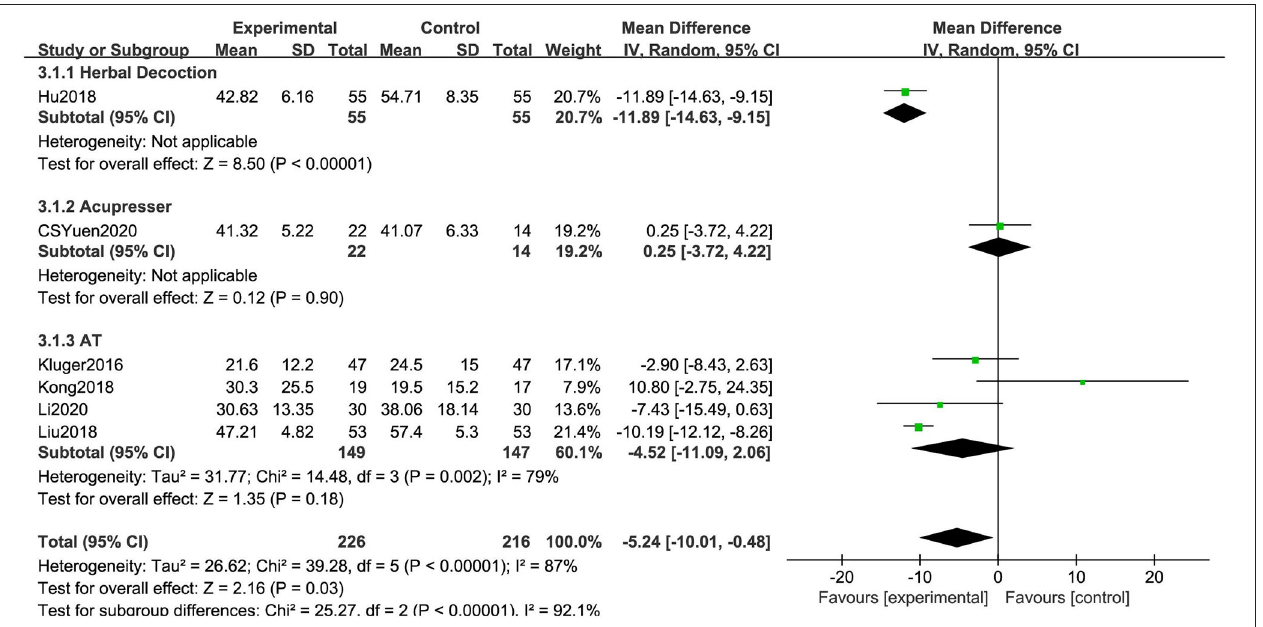
Frontiers in Aging Neuroscience |